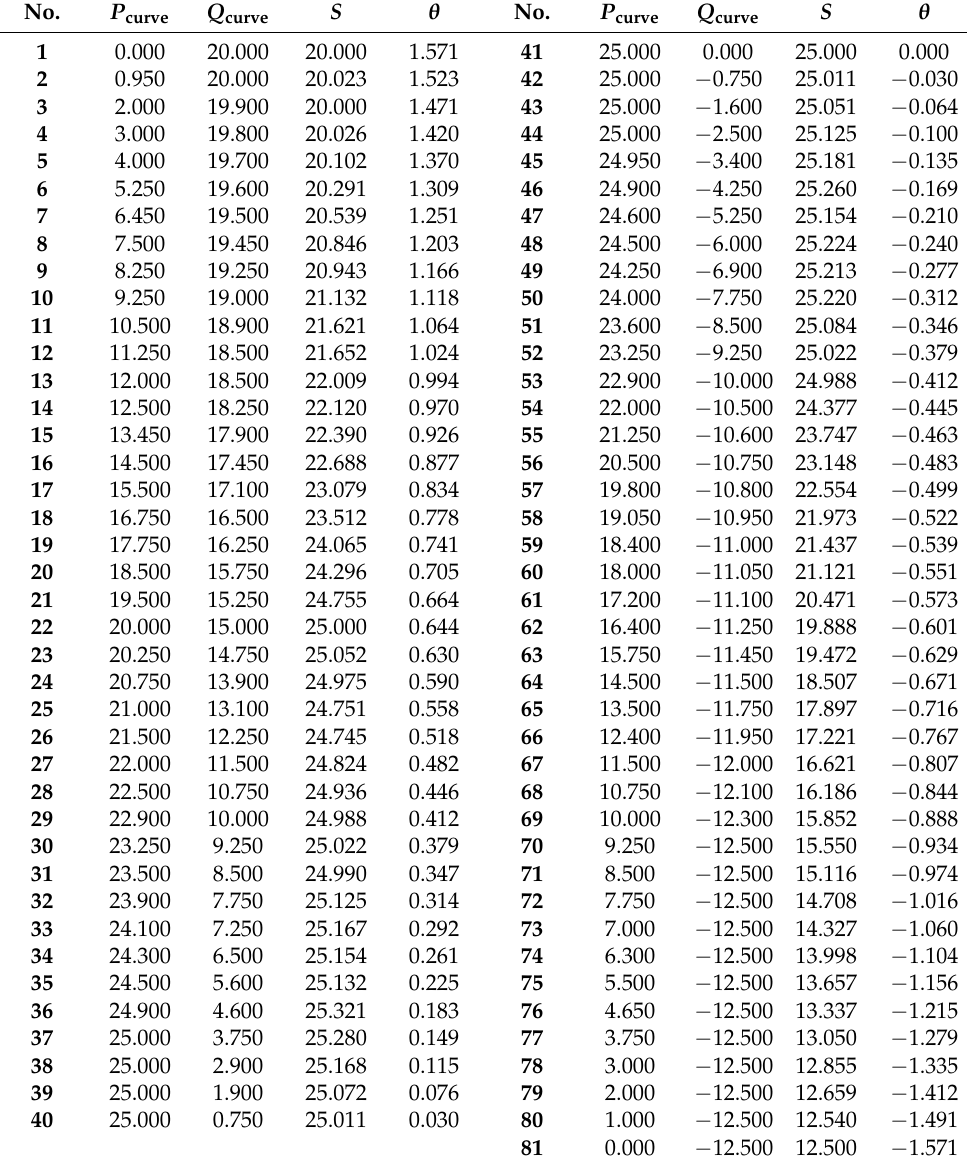
Table 3. The PQ curve data